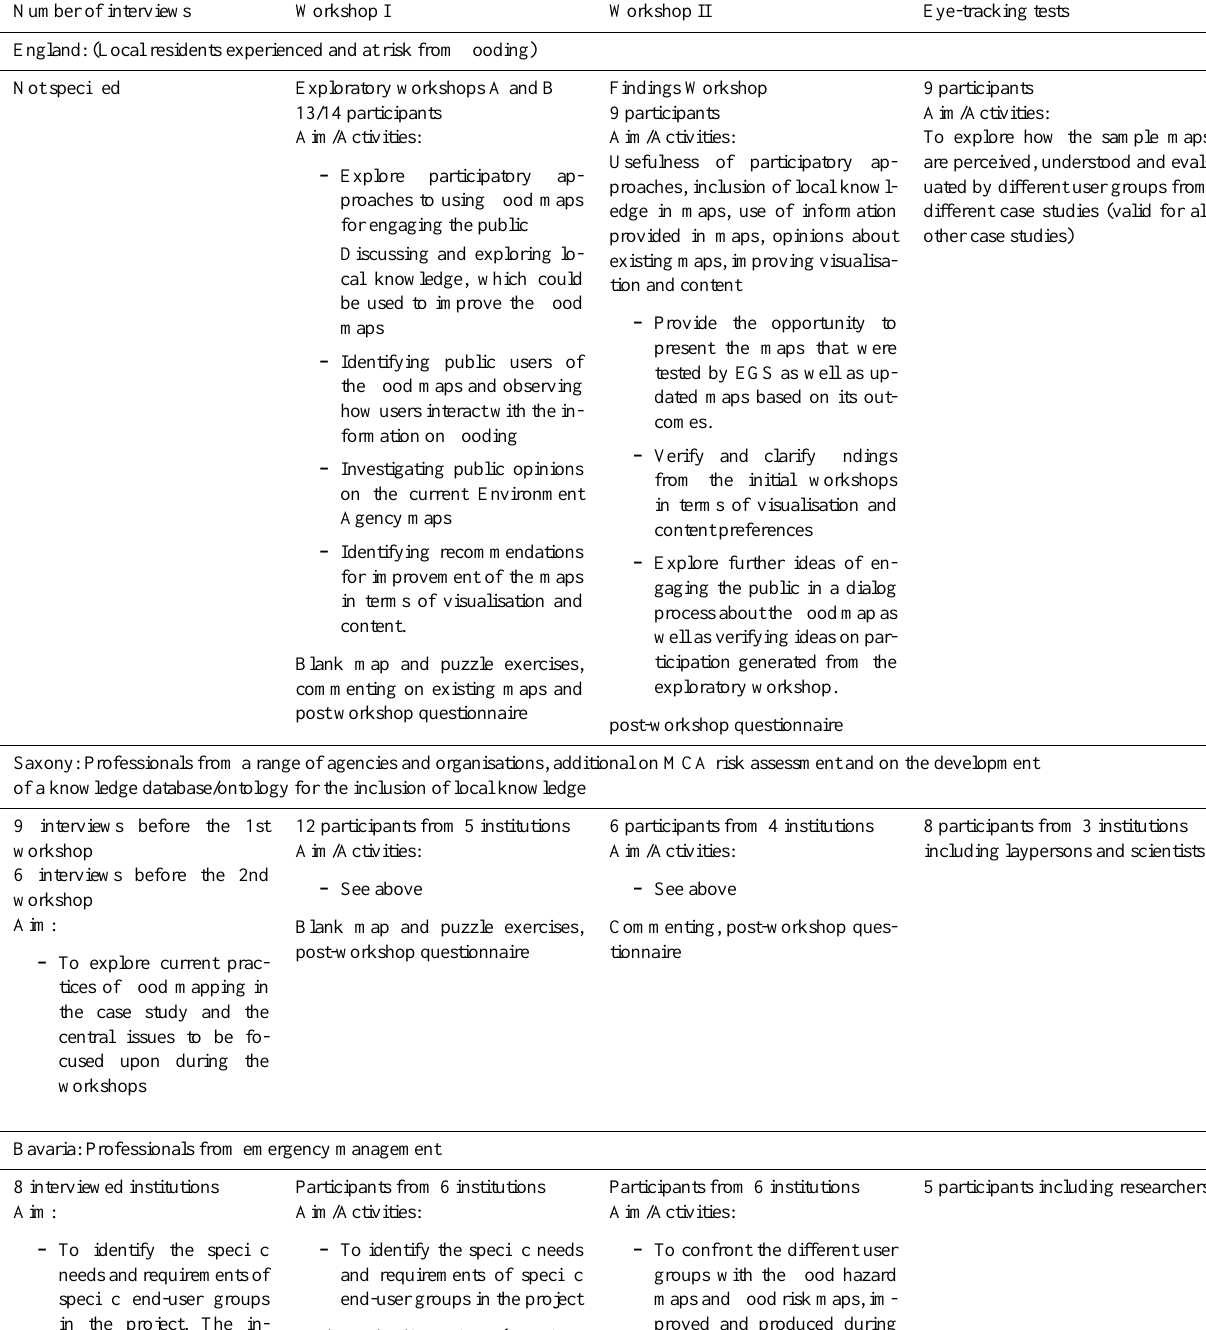
Table 1. Overview of the participatory process in RISK